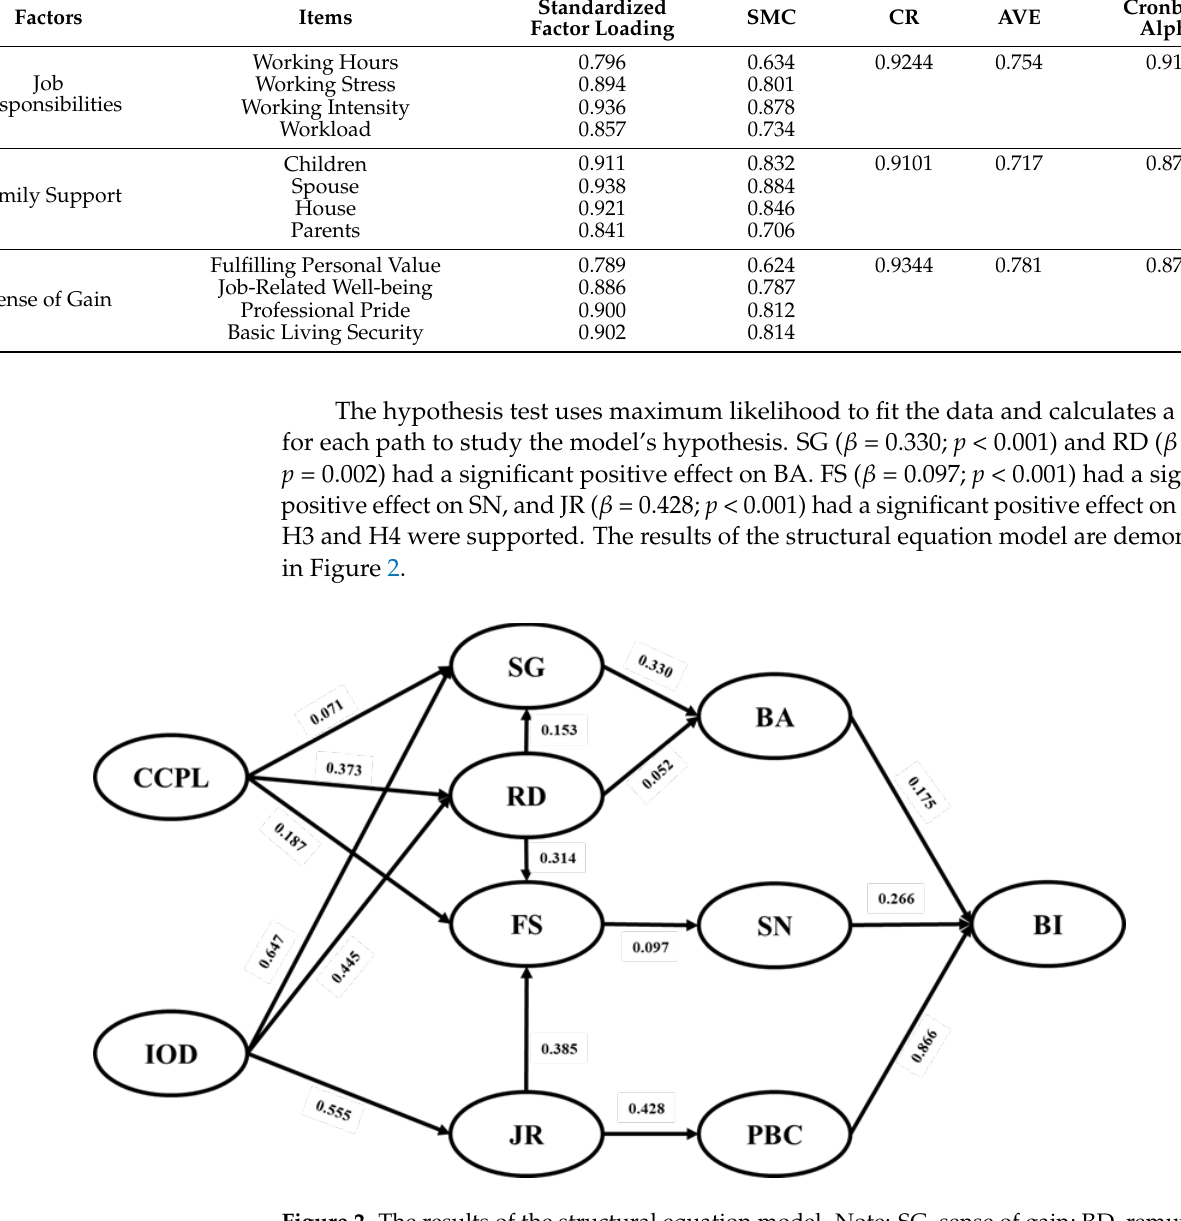
Table 4. The effects of factors on the three core variables of TPB.